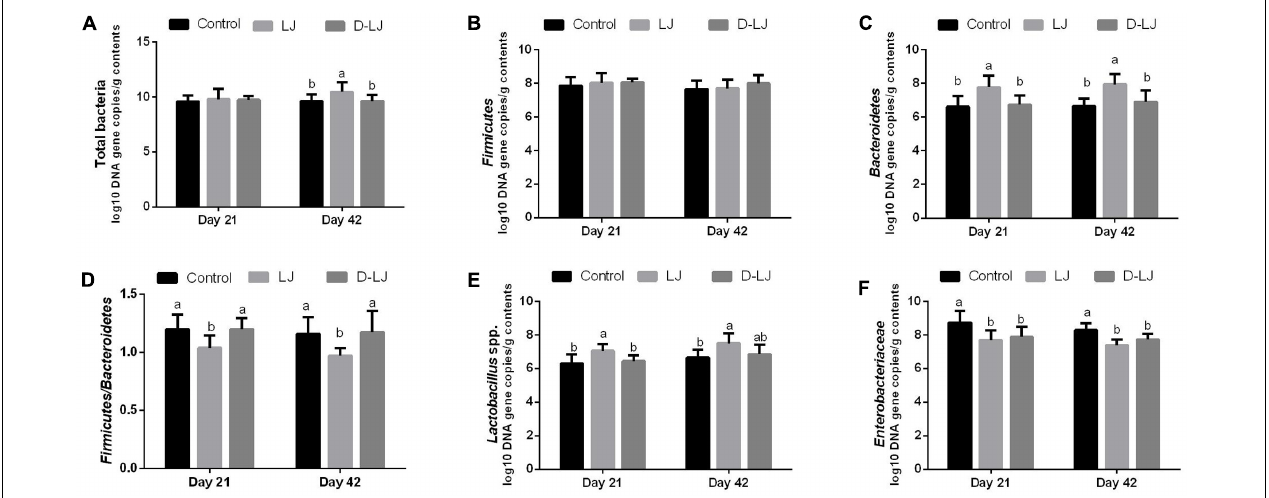
FIGURE 7 | Microbial populations in the ileum as quantified by quantitative PCR. Bars with different letters are significantly different on the basis of Duncan’s multiple range tests ( P < 0.05). Data are presented as mean ± standard deviation (six replicates of one chick per cage). (A–C,E–F) Log 10 DNA gene copies of total bacteria, Firmicutes, Bacteroidetes, Lactobacillus spp., and Enterobacteriaceae. (D) Firmicutes/Bacteroidetes